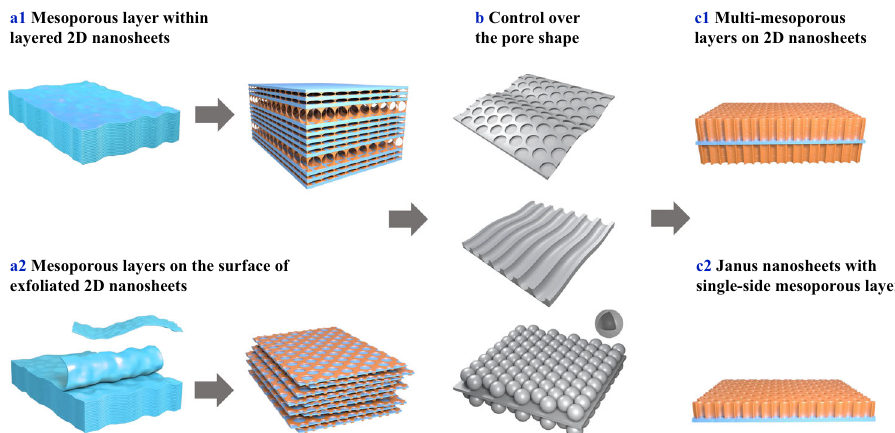
Fig. 1 Present and future prospects of 2D porous heterostructures. Construction of 2D porous heterostructures from ( a 1) layered 2D nanosheets and ( a 2) exfoliated 2D nanosheets. b Control over the pore shape of the mesoporous layer. Future design of a 2D porous heterostructure ( c 1) with multiple mesoporous layers and ( c 2) by using Janus